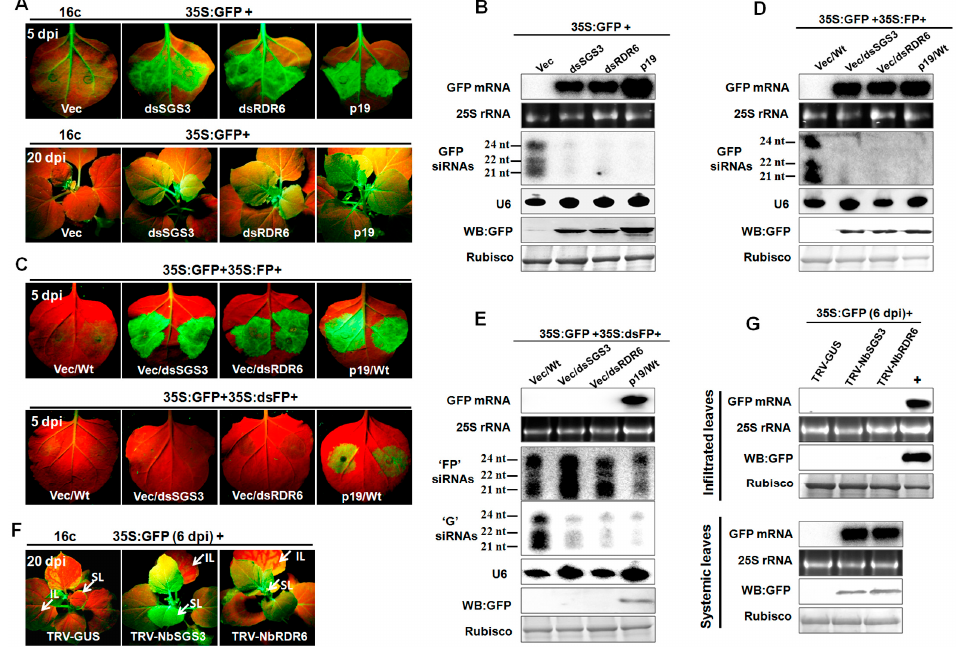
Figure 1. Reduced Nicotiana benthamiana SGS3 ( NbSGS3 ) expression suppresses sense-RNA induced post-transcriptional gene silencing (S-PTGS) and blocks the spread of systemic silencing. ( A ) Suppression of green fluorescent protein (GFP) silencing in N. benthamiana line 16c. Leaf patches were co-infiltrated with Agrobacterium tumefaciens cultures expressing GFP (35S:GFP) and either vector control (Vec), dsSGS3, double-stranded Nicotiana benthamiana RNA-dependent RNA polymerase (dsRDR6) or tomato bushy stunt virus (TBSV) p19. GFP fluorescence was photographed under UV light at 5 dpi (first row) and 20 dpi (second row); ( B ) accumulation of GFP mRNA, siRNAs and GFP protein in the infiltrated leaves shown in ( A ) at 5 dpi. For RNA blot analysis of mRNAs, [ α - 32 P]-labeled DNA fragments of GFP were used as probes and ethidium bromide staining of 25S rRNA was used as a loading control. For small RNA blot analysis, [ γ - 32 P]-labeled GFP or U6 oligonucleotides were used as probes. The size of the 21-, 22- and 24-nt RNAs are indicated. Protein levels were analyzed by immunoblot analysis using GFP monoclonal antibody. Coomassie blue staining of the large subunit of ribulose-1,5-bisphosphate carboxylase/oxygenase (Rubisco) served as a loading control; ( C ) GFP fluorescence in leaves of Wt, 35S:dsSGS3 or 35S:dsRDR6 transgenic N. benthamiana plants co-infiltrated with Agrobacterium cultures expressing 35S:GFP together with either a sense-PTGS trigger (35S:FP) (first row) or an inverted repeat of the GFP fragment (35S:dsFP) (second row) as indicated at the top of each panel. Plants were agroinfiltrated with 35S:GFP and the silencing triggers, together with vector (Vec) or p19 as indicated. Photographs were taken 5 dpi under UV light; ( D , E ) accumulation of GFP mRNA, siRNA and protein was detected in infiltrated leaves as described in ( C ). Labeled GFP oligonucleotides corresponding to the “FP”- and the “G”-regions of GFP were used to detect primary “FP”-siRNAs (1st siRNAs) and secondary “G”-siRNAs (2nd siRNAs), respectively; ( F ) function of NbSGS3 or NbRDR6 in initiation of systemic GFP silencing. 35S:GFP was infiltrated into 16c plants to induce local silencing, and after 6 days further infiltrated with TRV-GUS, TRV-NbSGS3 or TRV-NbRDR6. Photographs were taken 20 days post infiltration under UV light. Arrows indicate the infiltrated (IL) and systemic (SL) leaves; ( G ) accumulation of GFP mRNA and protein was detected in the infiltrated and systemic leaves as indicated in ( F ). “+” indicates RNA from a wild type 16c N. benthamiana leaf as a positive control. Coomassie blue staining of the large subunit of Rubisco served as a loading control.